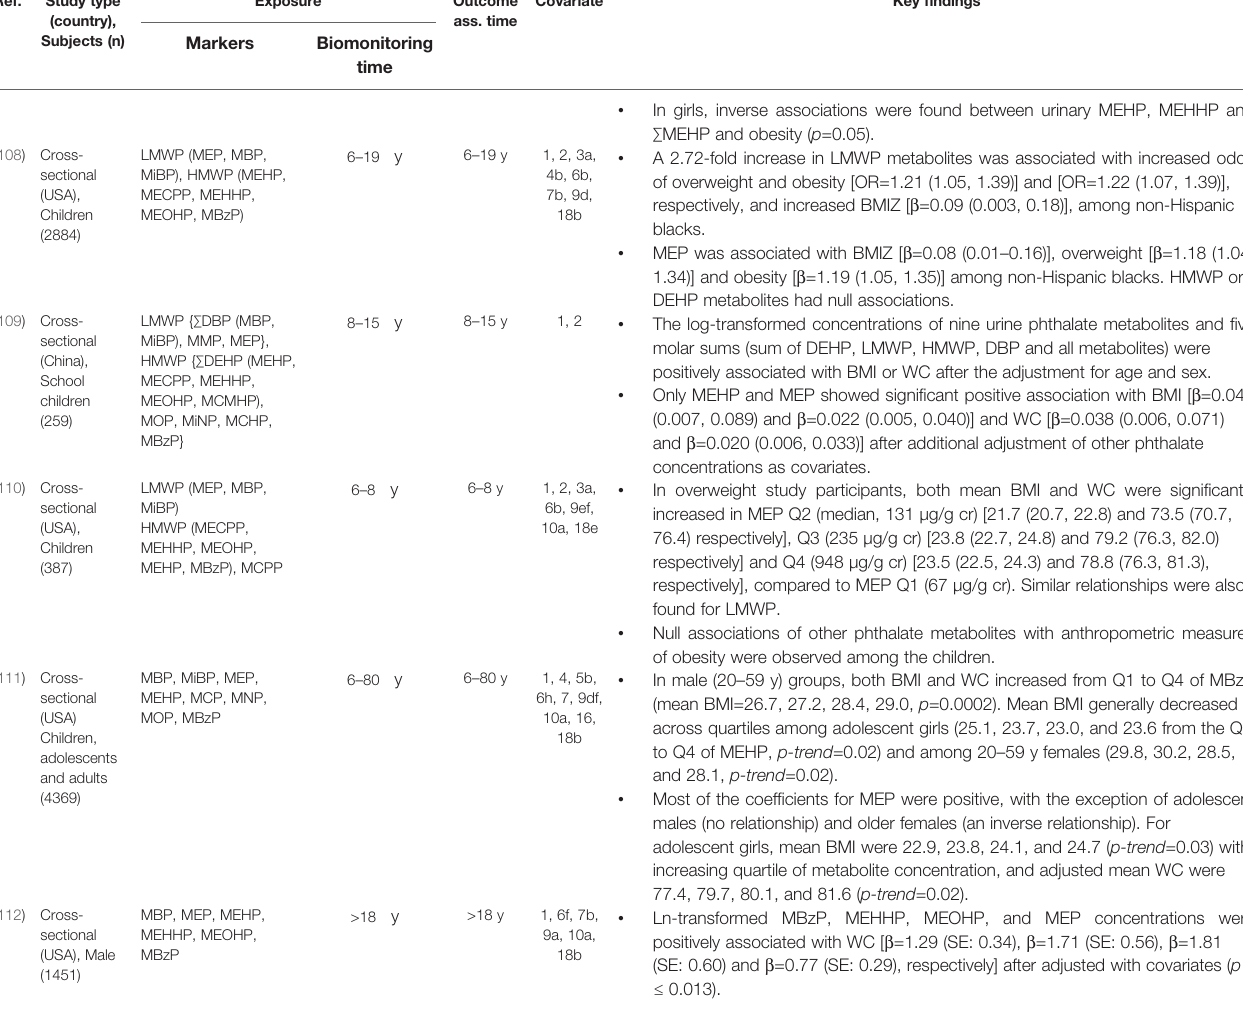
(109) Cross- The log-transformed concentrations of nine urine phthalate metabolites and fi ve (112) Cross- (cid:129) Ln-transformed MBzP, MEHHP, MEOHP, and MEP concentrations were